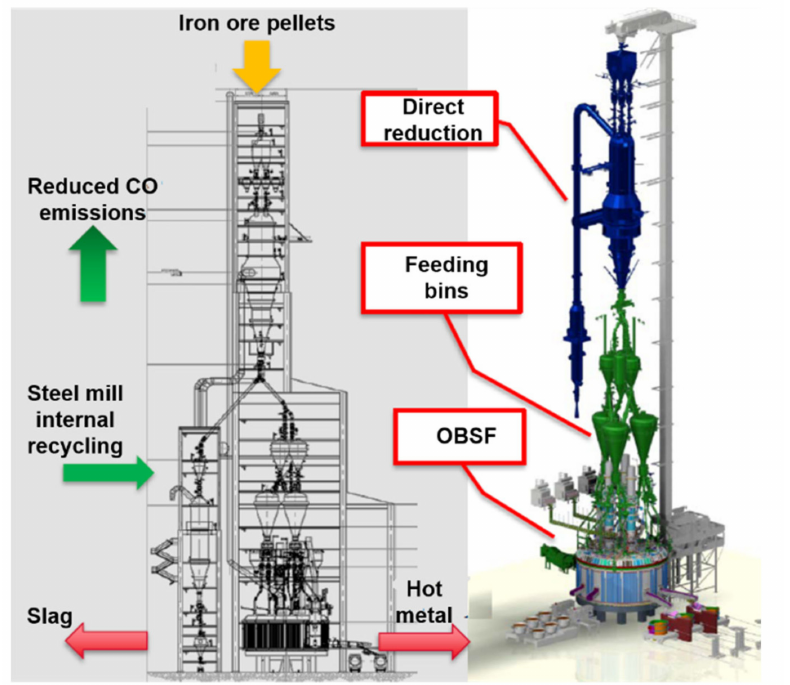
Figure 11. Schematic of an OBSF combined with a direct reduction plant